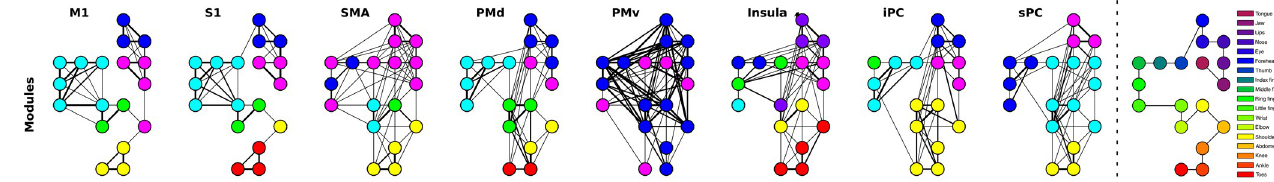
Fig 8. Body part modules. For each ROI, different modules are represented by different colors. Note that the colors only define a cluster of nodes within one graph, and any correspondence of colors between graphs is purely accidental. The whole-body graph layout is presented at the outmost right indicating the node-body part